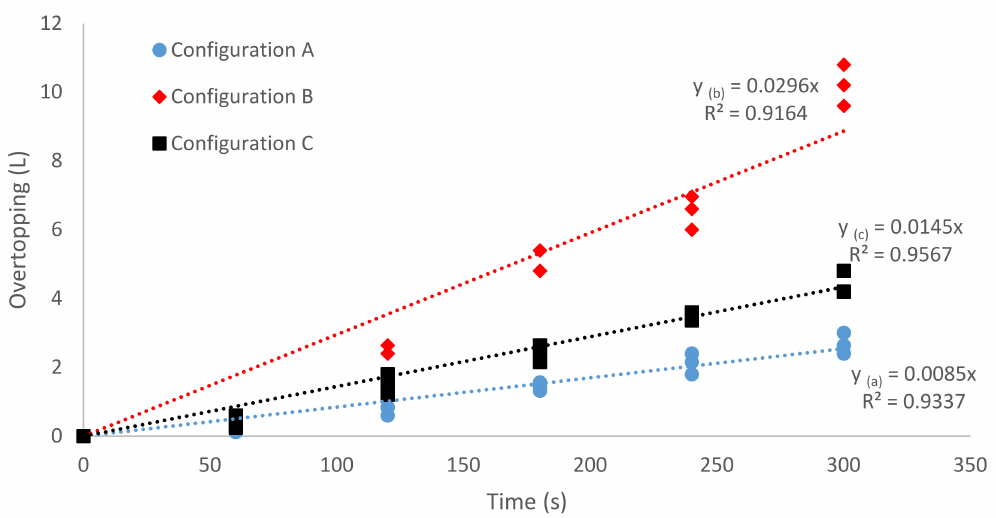
Figure 11. JONSWAP hydraulic conditions; overtopping measure; slope angle adopted within the experimental